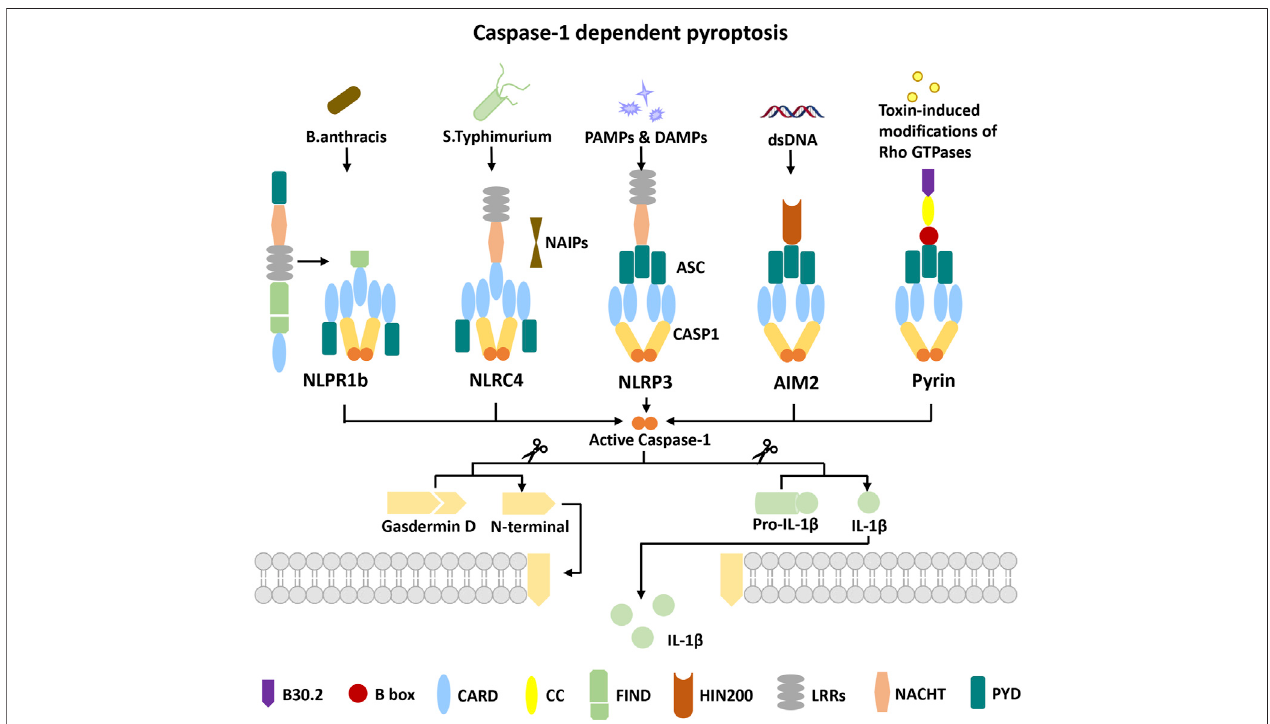
FIGURE 1 | Overview of fi ve in fl ammasome complexes. NLRP1 undergoes autocatalytic processing in its FIIND followed by proteasomal degradation of its autoinhibitory N-terminus to engage caspase-1 in the C-terminal CARD for its activation. NAIPs are necessary for NLRC4 in fl ammasome activation to recognize S. typhimurium . In NLRP1 and NLRC4 activation events, caspase-1 can be directly recruited independently of the adapter ASC. The NLRP3 in fl ammasome can be activated by a broad spectrum of exogenous and endogenous stimuli. AIM2 activation requires dsDNA of microbial or host origin in the cytosol. Toxin-induced modi fi cations ofRhoGTPasesreducethephosphorylationofpyrin,whichpromotestheassemblyofthepyrinin fl ammasome.NLRP3,AIM2,and pyrinactivationevents all require the adaptor ASC to activate caspase-1. Finally, activated caspase-1 drives gasdermin D cleavage to release the N-terminus, which forms the gasdermin D pore and drives pyroptosis. At the same time, activated caspase-1 cleaves pro-IL-1 β to mature IL-1 β into the extracellular matrix.